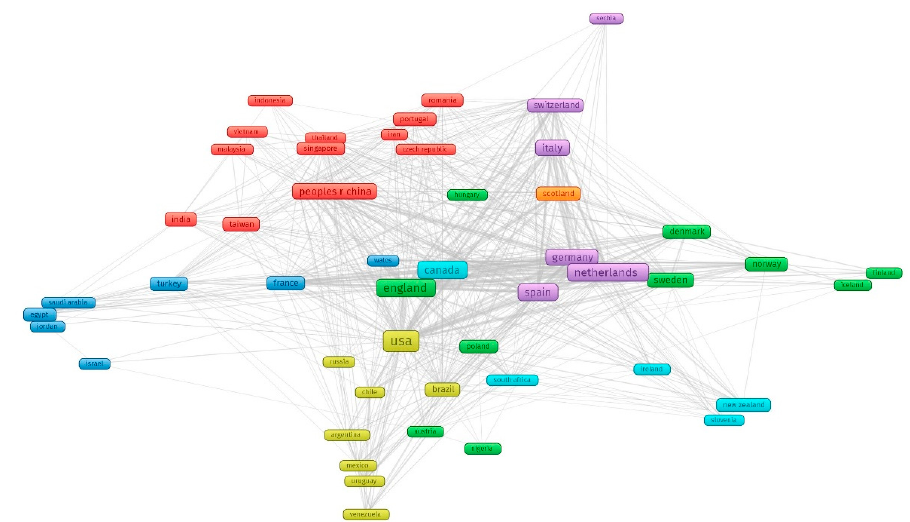
Figure 1. Countries collaboration network. Note: four main clusters, including (1) red cluster: Asia countries and two East European countries (Czech and Romania); (2) yellow cluster: the U.S and South American countries; (3) turquoise cluster Canada and South Africa, New Zealand and European countries; (4) the rest: European countries with three subgroups with the lead of France, the Netherlands and England.